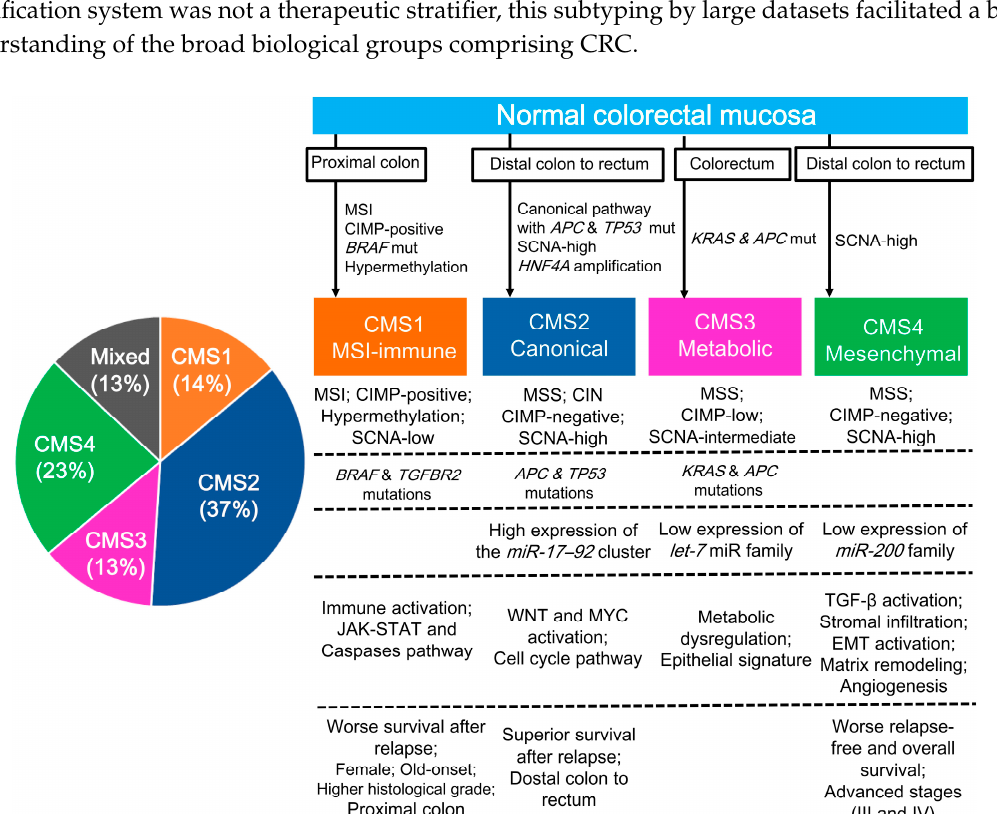
Figure 1. The taxonomy of colorectal cancer according to the Colorectal Cancer Subtyping Consortium, reflecting biological differences in the gene expression-based molecular subtypes [3]. CIMP, CpG island methylator phenotype; CIN, chromosomal instability; CMS, consensus molecular subtype; EMT, epithelial–mesenchymal transition; MSI, microsatellite instability; MSS, microsatellite stable; SCNA, somatic copy number alteration.